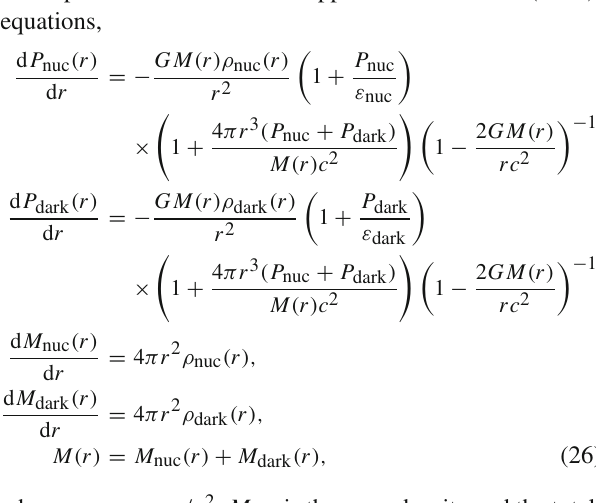
Fig. 3 Plotsofmassvs.centraldensityforstaticandrotatingfermionic asymmetric dark matter stars